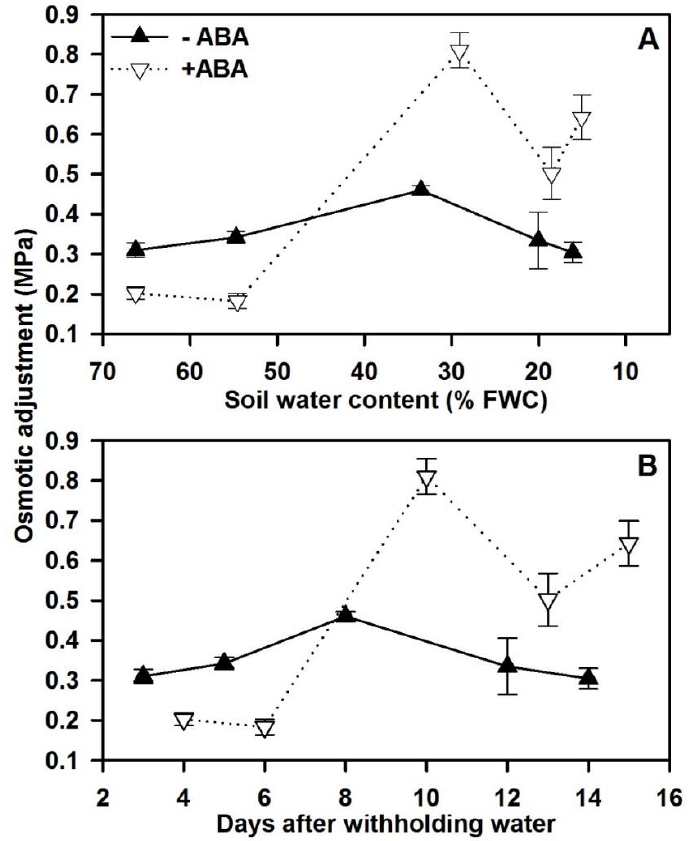
Figure 7. Changes in leaf osmotic adjustment (OA) with soil water content ( A ) and days after withholding water ( B ) in the soybean cultivar Jindou 19 (JD). One day before withholding water, plants were pretreated with (+ABA) or without (−ABA) 10 µM exogenous ABA. Values are means ± SE ( n = 3).